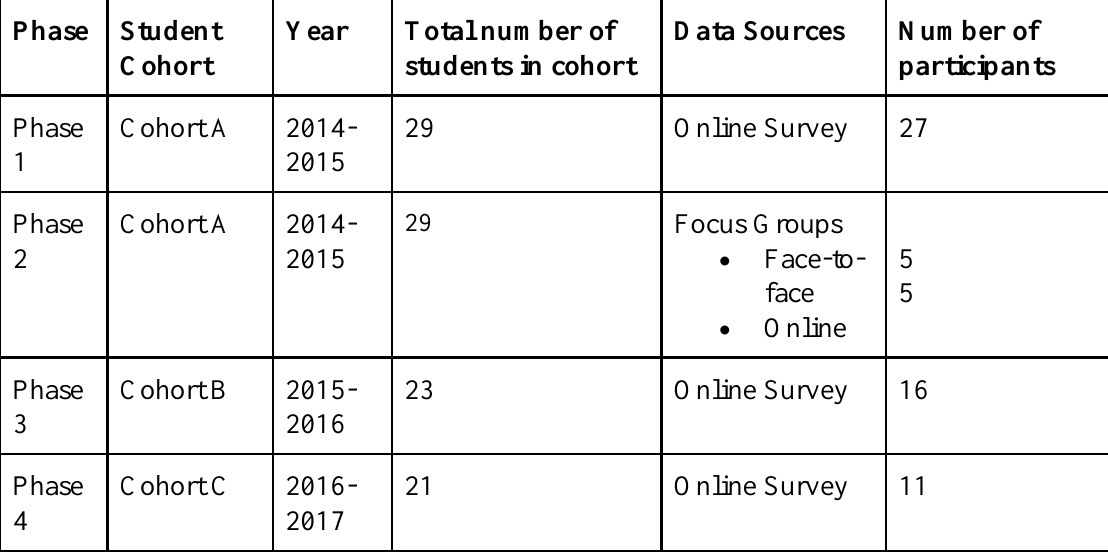
Table 1: Data Collection in Each Phase